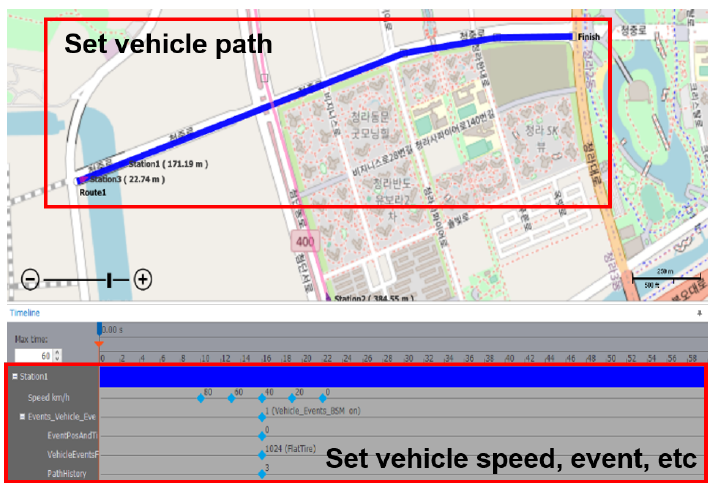
Figure 9. The simulation editor of the simulation equipment used in this paper. Using the scenario editor, the user can specify vehicle nodes’ routes, speeds, and events. When the simulation is executed, each vehicle node drives according to the scenario specified by the